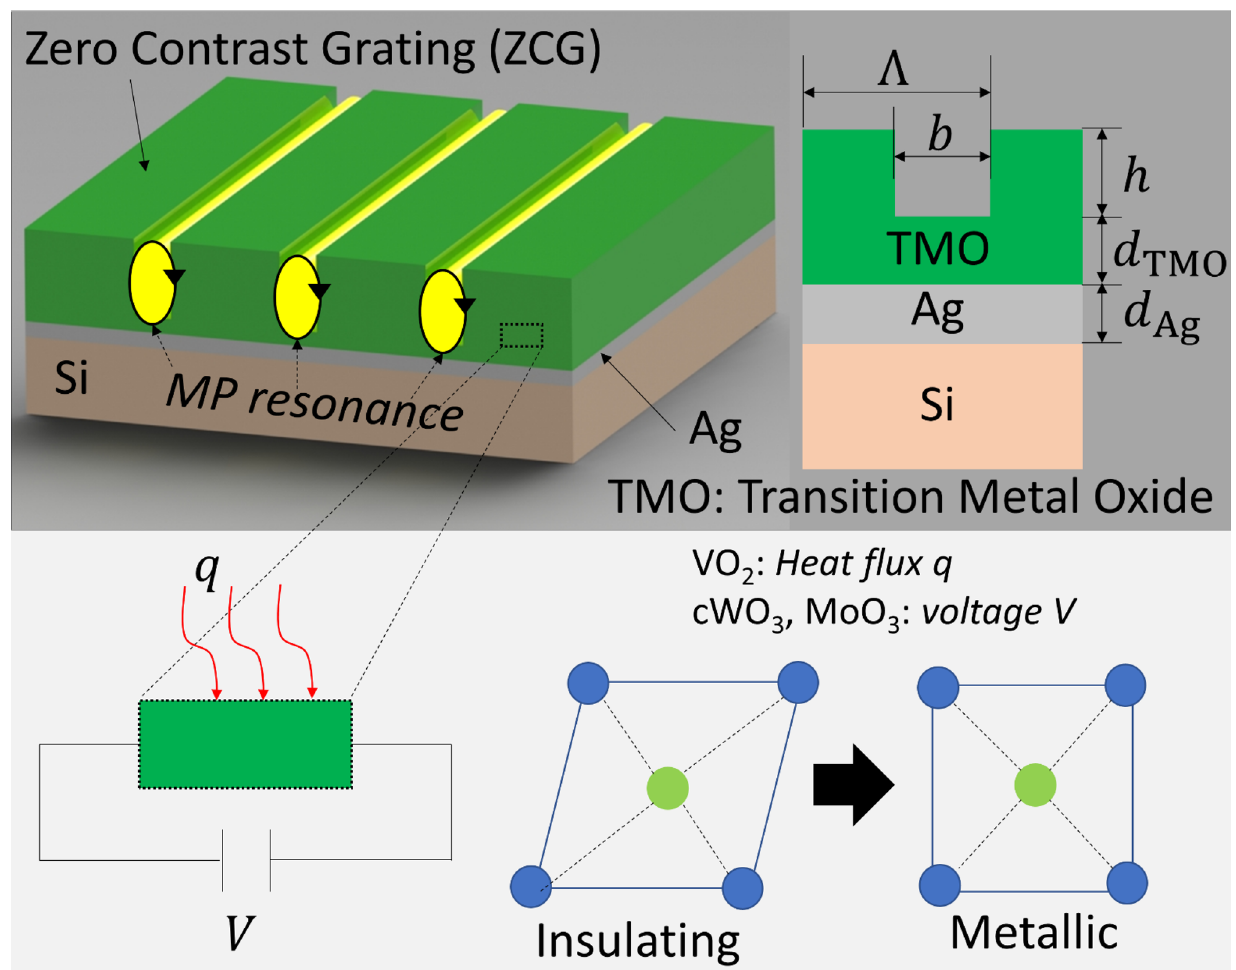
Figure 1. Schematic of transition metal oxide (TMO) grating with period Λ, height h and width b on TMO underlayer ( d TMO ) and Ag underlayer ( d Ag ). TMO undergoes phase transition from insulating phase to metallic phase when temperature is applied (VO 2 ) or voltage is applied (cWO 3 and MoO 3 grating (ZCG) which is an opposite structure to the high contrast grating (HCG). HCG is a grating made of high-index material surrounded by low index medium to obtain high reflectance 43,47 . By applying ZCG on the reflective material, the transmitted light is reflected back to create a perfect mirror in wider range of wavelength compared to HCG. Hence, the reflection band can be directly converted to zero absorptance because of opaque- ness ( α = 1 – ρ ), whereas the narrowband transmittance due to waveguide interference (even waveguide mode) is converted as a narrowband absorptance. This is the case for non-Lorentz material such as MoO 3 . Second, with Lorentz oscillation, the reflection band is split into two where two different waveguide mode (single and even waveguide mode) is excited, creating a dual-mode region, similar to HCG. Consequently, multiple absorption peaks are produced because of these two waveguide modes. Therefore, cWO 3 and VO 2 have combined effect of ZCG and phonon modes, resulting in mix of two transmission modes split with the presence of phonon. As shown in the electromagnetic field distribution, it results in confining electromagnetic fields both in grooves and gratings. On the contrary, MoO 3 only has electromagnetic field confinement in the grating as an even waveguide mode, which result in small absorption peaks. This tells how transparency throughout a wide range of infrared light is significant to obtain broader reflectance using ZCG. The emissive power at insulating phase is 51.6 and 116 W/m 2 (at 300 K) for VO 2 and cWO 3 while MoO 3 only has 3.15 W/m 2 . Therefore, as summarized in Table 1, MoO